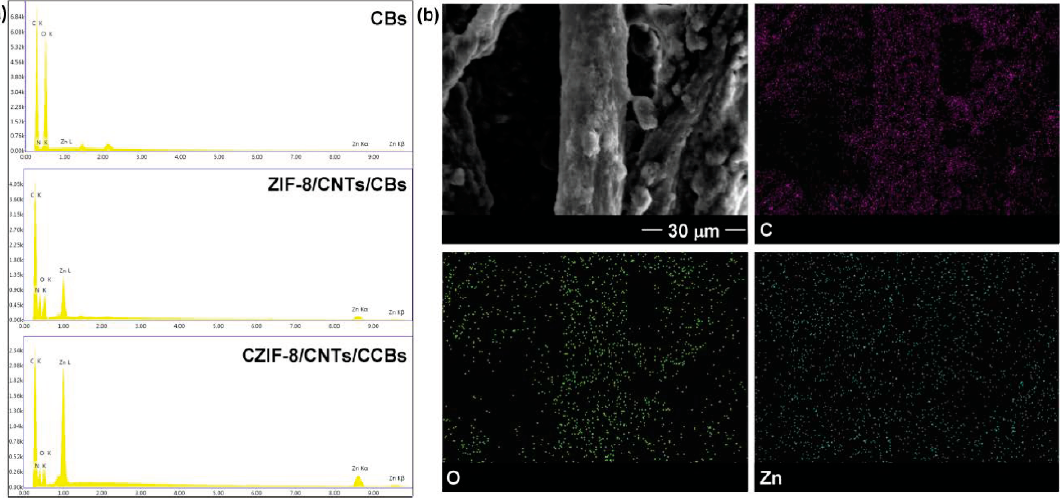
Figure 5. ( a ) Images of CBs, ZIF-8/CNTs/CBs, and CZIF-8/CNTs/CCBs EDS elemental analysis spectra. ( b ) Images of CZIF-8/CNTs/CCBs in EDS elemental mappings. The crystalline structures of CBs, ZIF-8/CNTs/CBs, and CZIF-8/CNTs/CCBs were investigated using XRD patterns (Figure 6b). It can be seen that there are three typical diffraction peaks at 14.8 ◦ , 16.5 ◦ , and 22.9 ◦ , which were assigned to the (1–10), (110), and (200) lattice planes of cellulose in the CBs, respectively [37]. The XRD pattern of ZIF- 8/CNTs/CBs shows six characteristic peaks at 7.3 ◦ , 10.4 ◦ , 12.9 ◦ , 14.7 ◦ , 16.4 ◦ , and 18.2 ◦ , which can be ascribed to the (011), (002), (112), (022), (013), and (222) lattice planes of ZIF-8, respectively [33]. Moreover, the XRD pattern of CZIF-8/CNTs/CCBs possesses only one weak and broad diffraction peak at 26.1 ◦ , corresponding to the (002) lattice plane of the graphite-structure crystallites of CCBs [38]. These XRD results further verify the successful preparation of ZIF-8 on the surface of the